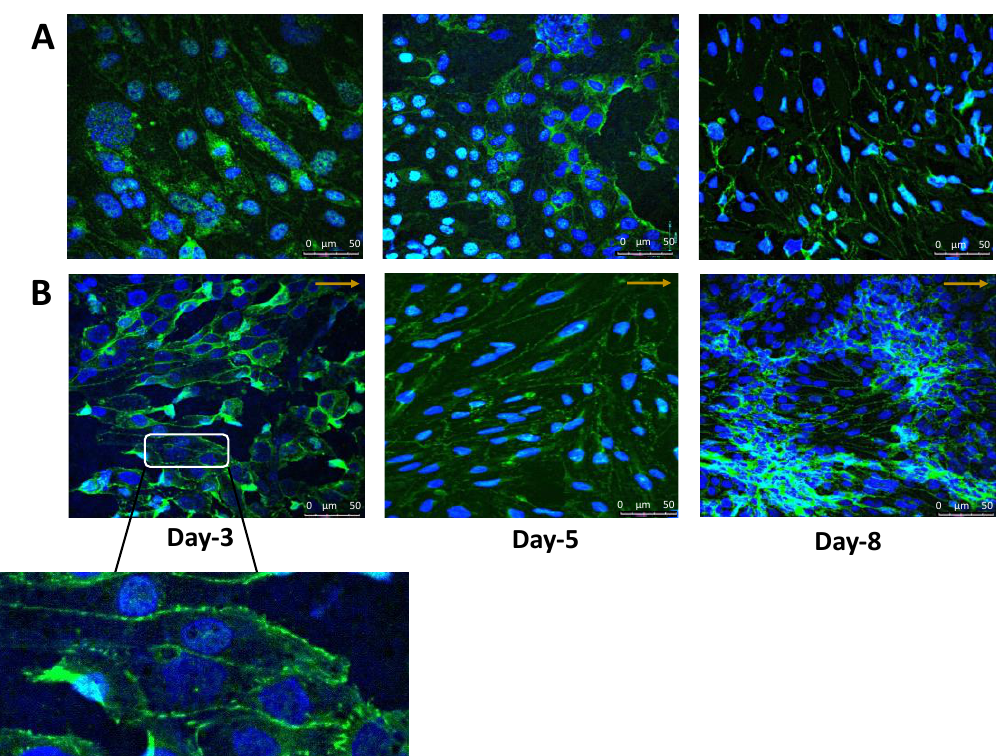
Figure 5. Endothelial cells grow in the direction of the laminar flow in dynamic BBB model. BBB was cultured under static conditions ( A ) or under a laminar flow of 4–15 dyn/cm 2 ( B ) for 8 days Confocal images obtained following staining of the hCMEC/D3 cells for DAPI (blue), and ZO-1 (green) merged when grown on collagen-coated microporous membranes. Arrows indicate the direction of the flow. Images were taken using an UltraVIEW confocal microscope.